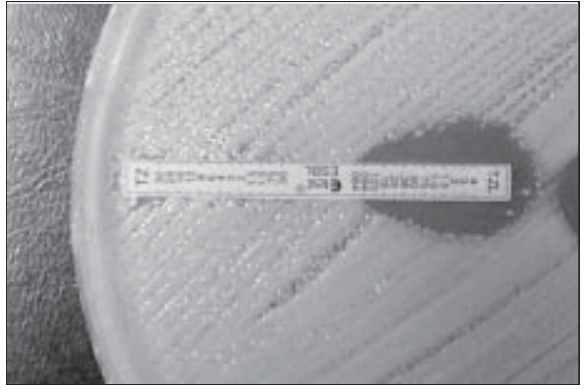
Figura 3 – Etest ESBL Screen ® positivo para o substrato ceftazidima em amostra de K. pneumoniae . Observa-se a diminuição da CIM para ceftazidima/ácido clavulânico. CIM TZ/TZL ≥ 32/0,0125 (cid:181) g/ml. TZ = ceftazidima; TZL = ceftazidima + ácido